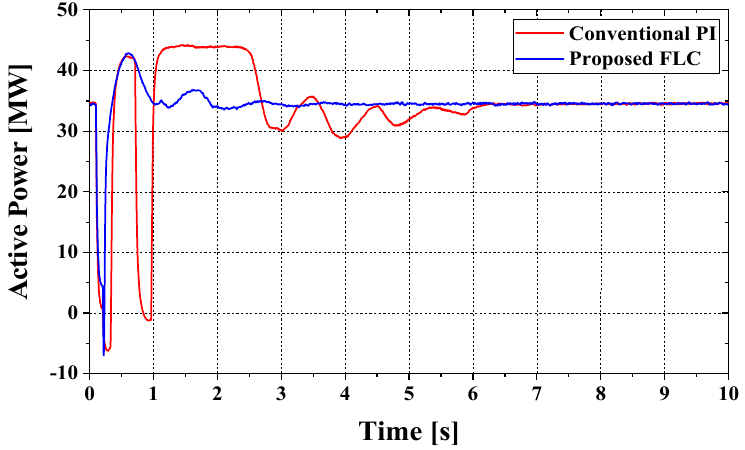
Figure 11. Active power profile of the conventional and proposed PV plants.